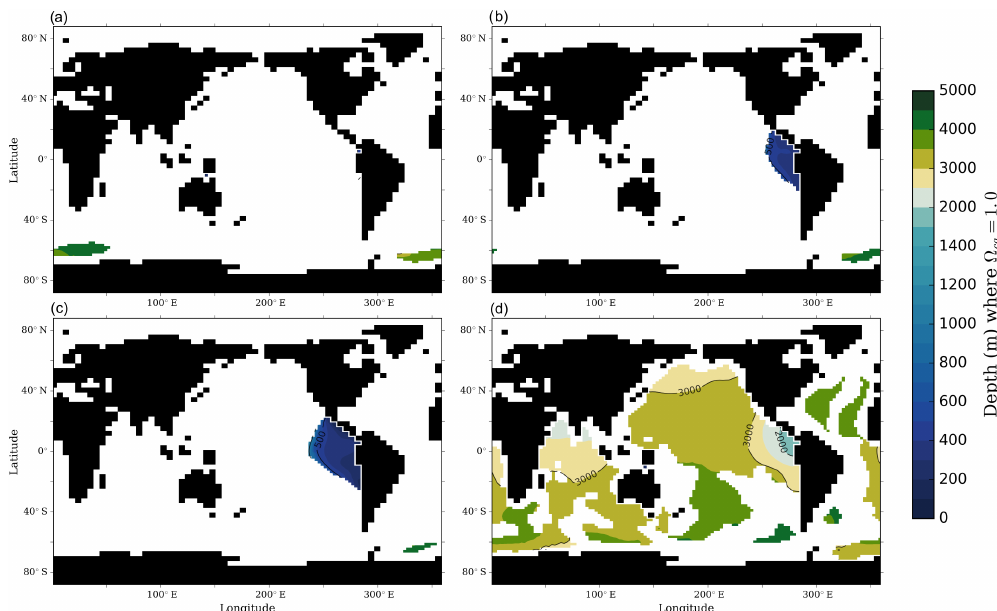
Figure 11. The depth at which calcite becomes undersaturated in the water column (where (cid:127) ca = 1) for the experiments with modified biogeochemical formulations. (a) O-LGM BGC poc , (b) O-LGM BGC rem , (c) O-LGM BGC regions where calcite is completely saturated throughout the water